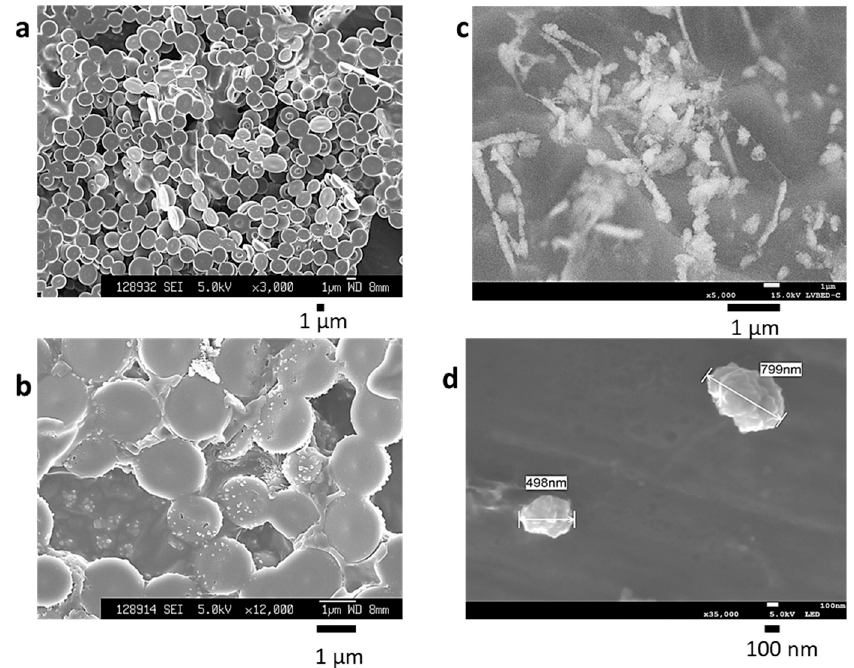
Figure 1. Scanning electron microscopy (SEM) images of drying BiSCaO Water and cryo-SEM images of BiSCaO Water. The particle surface structure of drying BiSCaO Water at 3000-fold magnification ( a ) and at 12,000-fold magnification ( b ) was observed with SEM images taken with a field-resolved scanning electron microscope. Cryo-SEM observations were performed on BiSCaO Water at 5000-fold magnification ( c ) and 35,000-fold magnification ( d ). Arrows indicate nanoparticles comprising